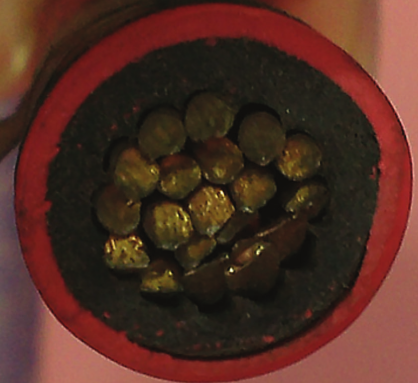
Figure 2: Single-core insulated cable for electrical power transmis- sion.